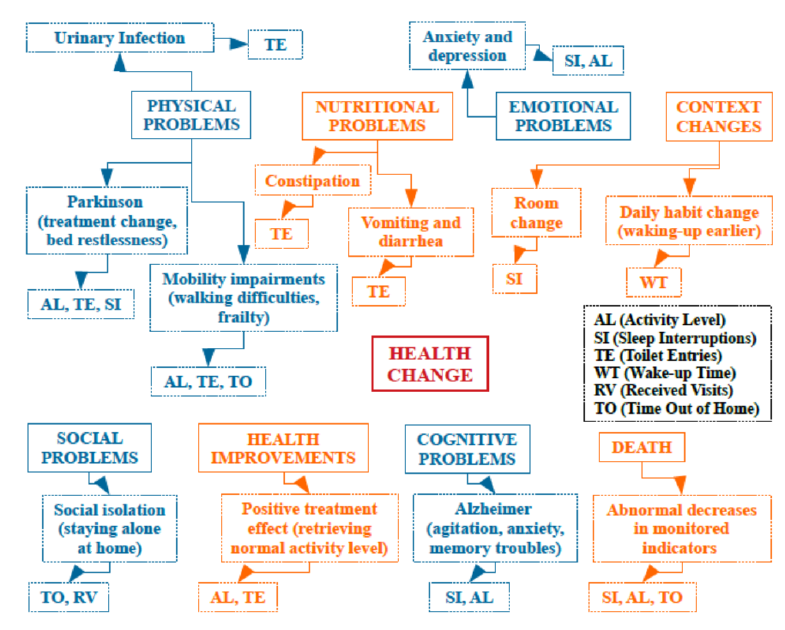
Figure 12. Health change detection